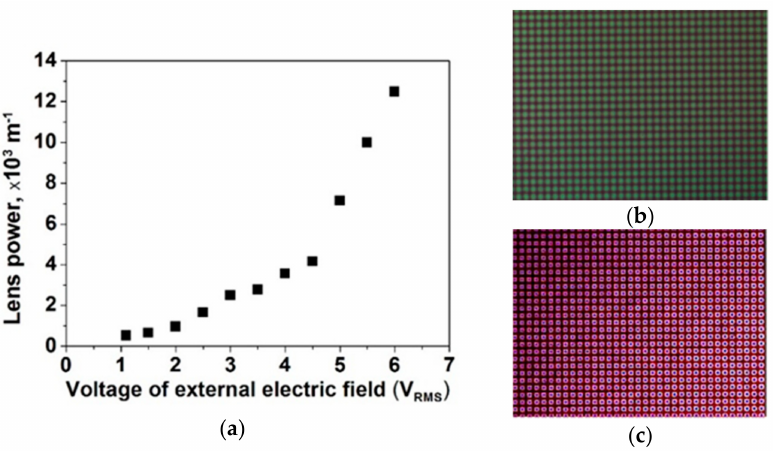
Figure 3. The experimental results of LC-MLA. ( a ) The relationship between the lens power and voltage of the external electric field; ( b ) The white image of the LC-MLA at 0 V rms ; ( c ) The calibration information of the